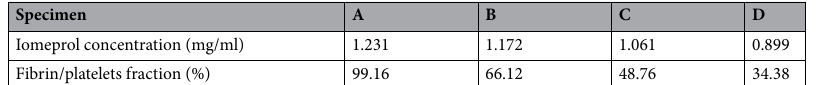
Table 4. Representative four samples in which a sufficiently high iomeprol concentration has resulted. In addition, the corresponding volume fractions of fibrin/platelets are given.